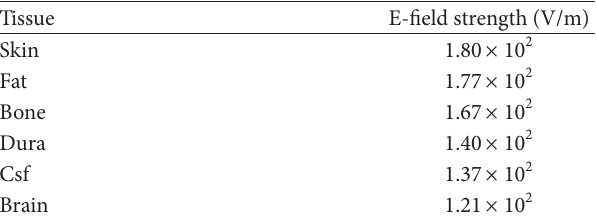
T 4: �-�eld strength in six-layer model, dipole antenna.